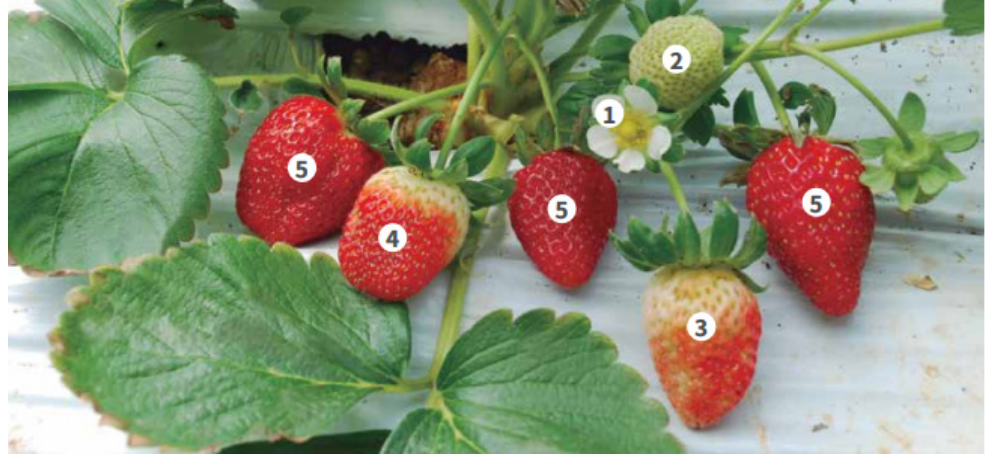
Figure 5. Strawberry development and ripening stages: 1—Flower (Inflorescence); 2—Unripe fruit; 3—Fruit with less than 3/4 of reddish surface; 4—Fruit with more than 3/4 (75%) of reddish surface; 5—Fully ripe fruit. Fruit classification according to Incaper [44].